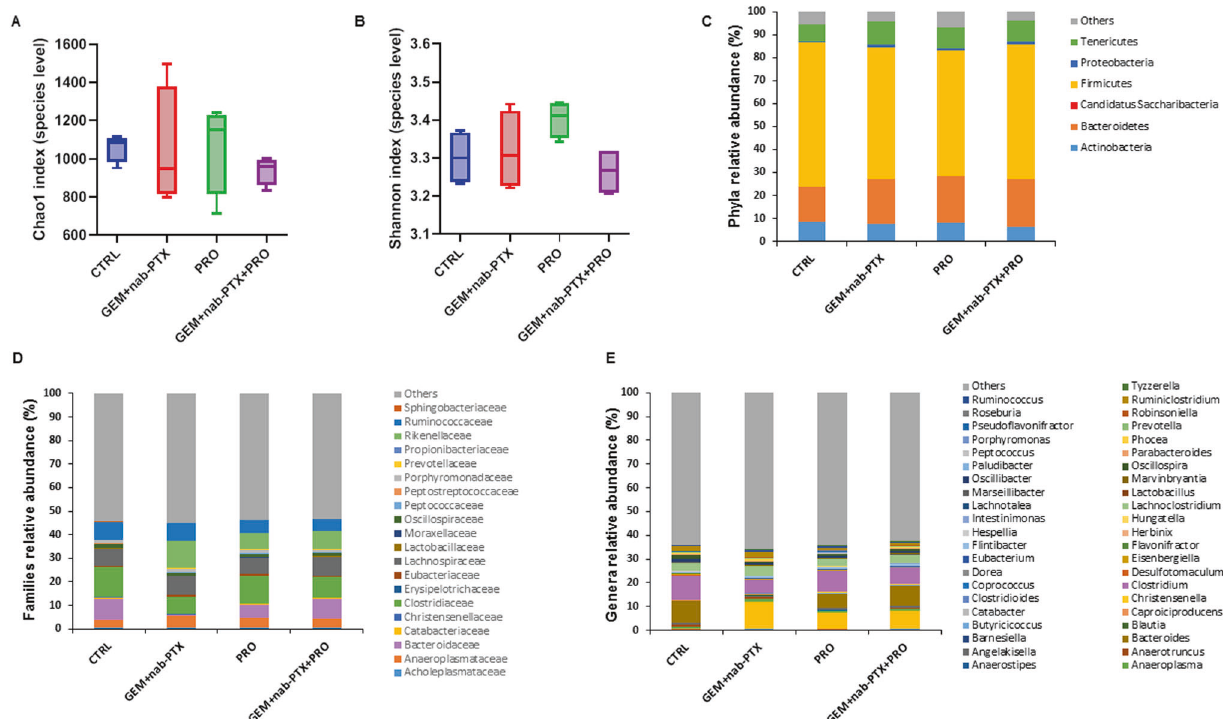
Fig. 6 Effect of chemotherapy and/or probiotic treatment on gut microbiota alpha-diversity and taxonomic composition in PANC-1 bearing mice. Boxplots representing species-level richness expressed by Chao1 index ( A ) and diversity expressed by Shannon Index ( B ) in the four experimental groups. Data are expressed as means of four fecal pools per group. Stacked barplots showing the mean relative abundance of gut bacteria at the phylum ( C ), family ( D ), and genus ( E ) level. Data are expressed as means of four fecal pools per experimental